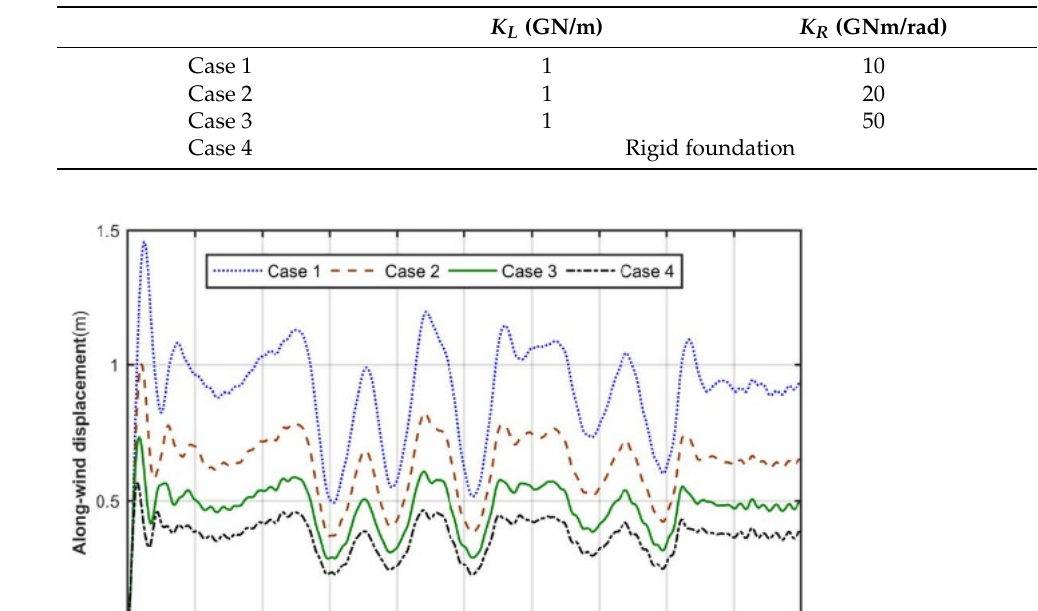
Table 5. Simulation analysis foundation case.